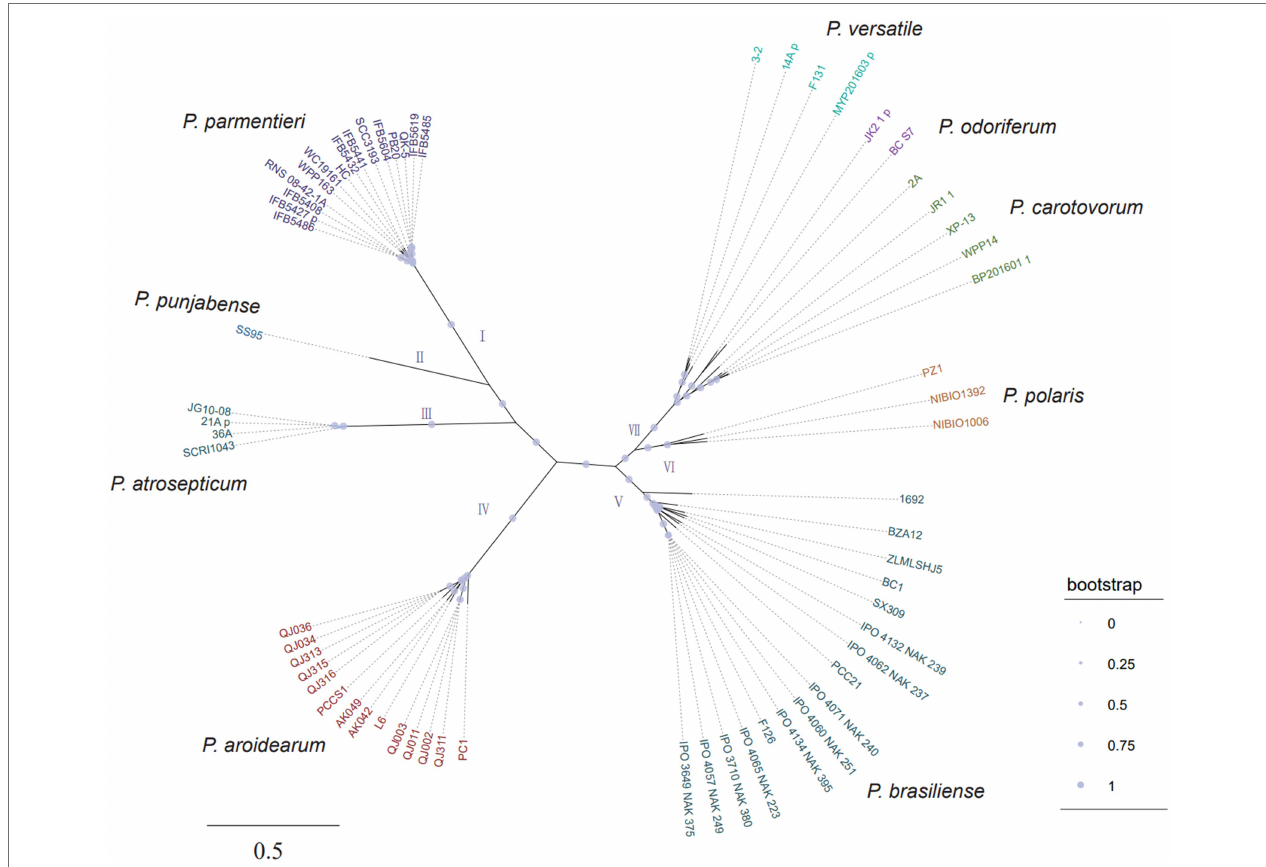
FIGURE 2 | The unrooted parsimony tree of 64 Pectobacterium strains based on all SNPs. The consensus parsimony tree was constructed by kSNP3 and visualized by iTOL. The support values were calculated by FastTreeMP. Branch lengths are expressed in terms of changes per number of